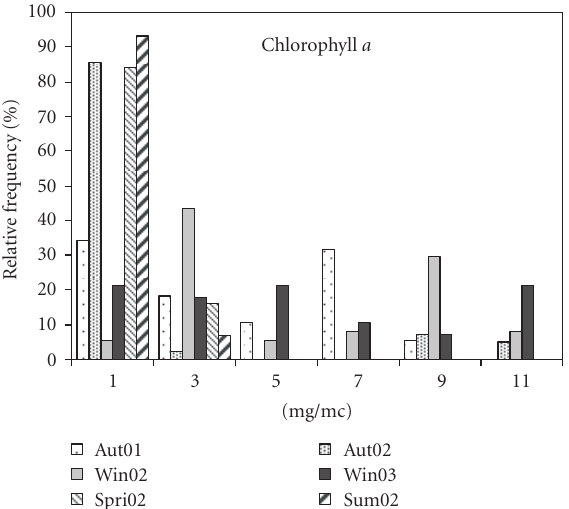
Figure 9: Chlorophyll a seasonal distribution in frequency classes (autumn 2001–winter 2003). Labels report the class lower